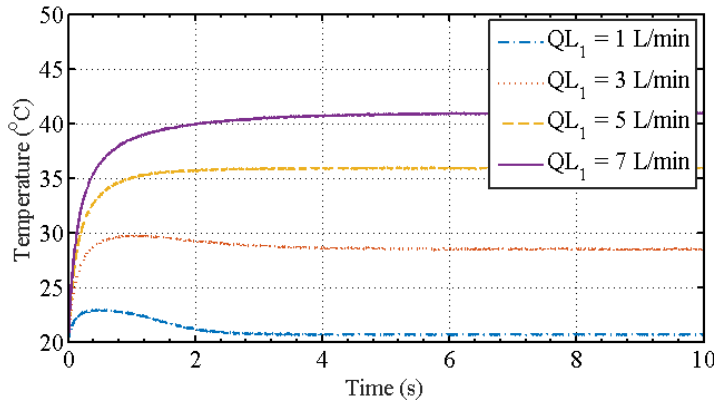
Table 5. The relationships between the output temperature of cold fluid and the flow rates of hot fluid, cold fluid for the proposed parallel model of the spiral-plate parallel-flow heat exchanger. Figure No. Descrption Figure 20 q 1 , q 2 = 0.9, 0.92, 0.94, 0.96, 0.98, 1.0 Figure 21 q 1 , q 2 = 1.004, 1.008, 1.01, 1.02 Figure 22 QL 1 =1 L/min, QL 2 = 1, 3, 5, 7 L/min Figure 23 QL 1 =3 L/min, QL 2 = 1, 3, 5, 7 L/min Figure 24 QL 1 =5 L/min, QL 2 = 1, 3, 5, 7 L/min Figure 25 QL 1 =7 L/min, QL 2 = 1, 3, 5, 7 L/min Figure 26 QL 1 = 1, 3, 5, 7 L/min, QL 2 = 1 L/min Figure 27 QL 1 = 1, 3, 5, 7 L/min, QL 2 = 3 L/min Figure 28 QL 1 = 1, 3, 5, 7 L/min, QL 2 = 5 L/min Figure 29 QL 1 = 1, 3, 5, 7 L/min, QL 2 = 7